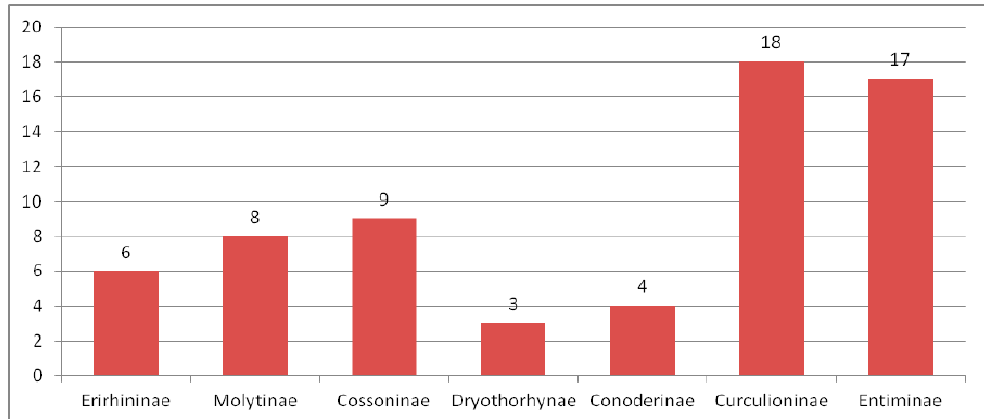
Figure 17. Composition of species of Curculionidae in the Baltic amber.